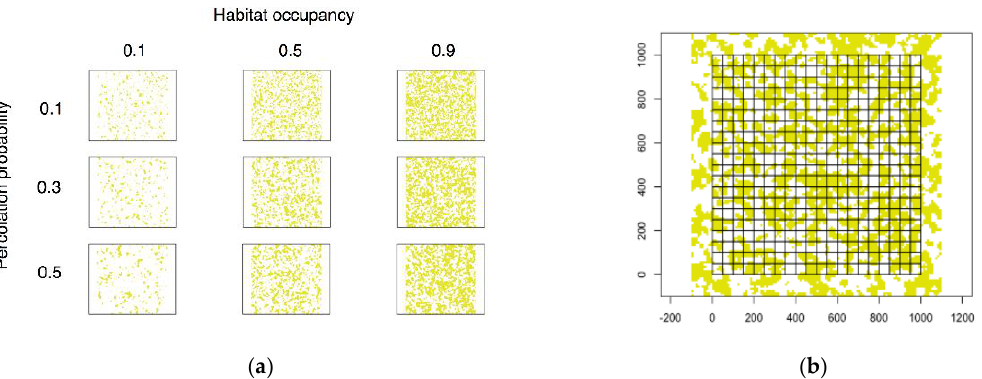
Figure 1. Simulated landscapes. ( a ) Modified Random Clusters landscapes with varying habitat (forest) occupancy and percolation probability. Forest cells are yellow, non-forest are white; ( b ) Simulated landscape with overlaid quadrats.